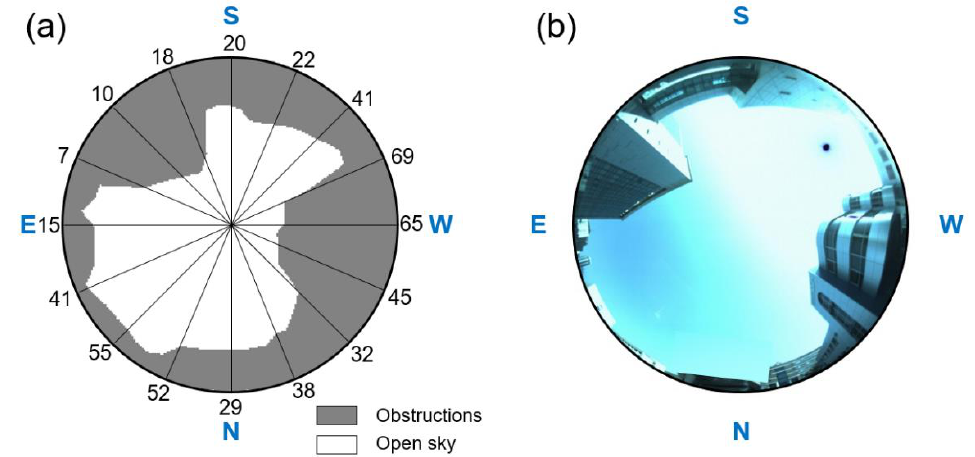
Figure 3. Skymaps generated using ( a ) hemispherical viewshed technique applied to a 3D model and ( b ) fisheye lens camera. Gray areas depict shading obstructions. Numbers represent the maximum horizon angle between the survey point and the shading obstruction at each azimuth angle.